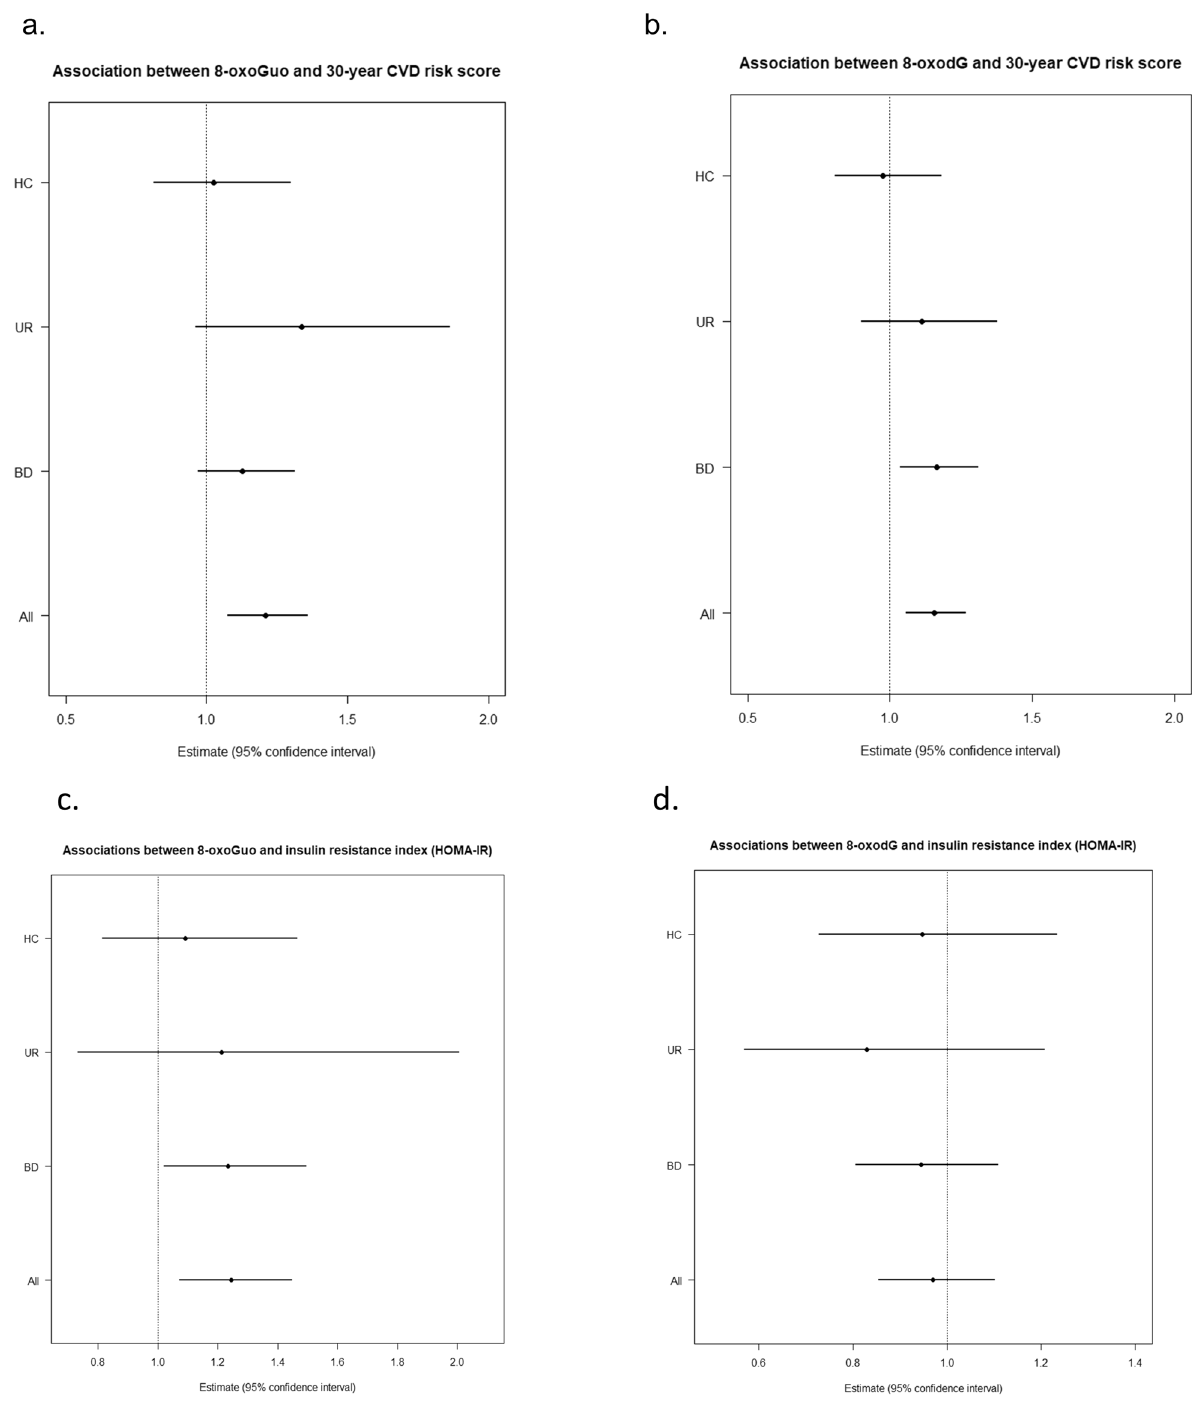
Fig. 2 Associations between cardiovascular disease risk measurements and oxidative stress comparing participant groups. Forest plots of associations between 30-year cardiovascular disease risk score and levels of 8-oxoGuo ( a ) and 8-oxodG ( b ) and insulin resistance index and levels of 8-oxoGuo ( c ) and 8-oxodG ( d ), comparing total study population ( “ All ” ) with the three subgroups: BD patients with bipolar disorder; UR unaffected relatives, HC healthy control